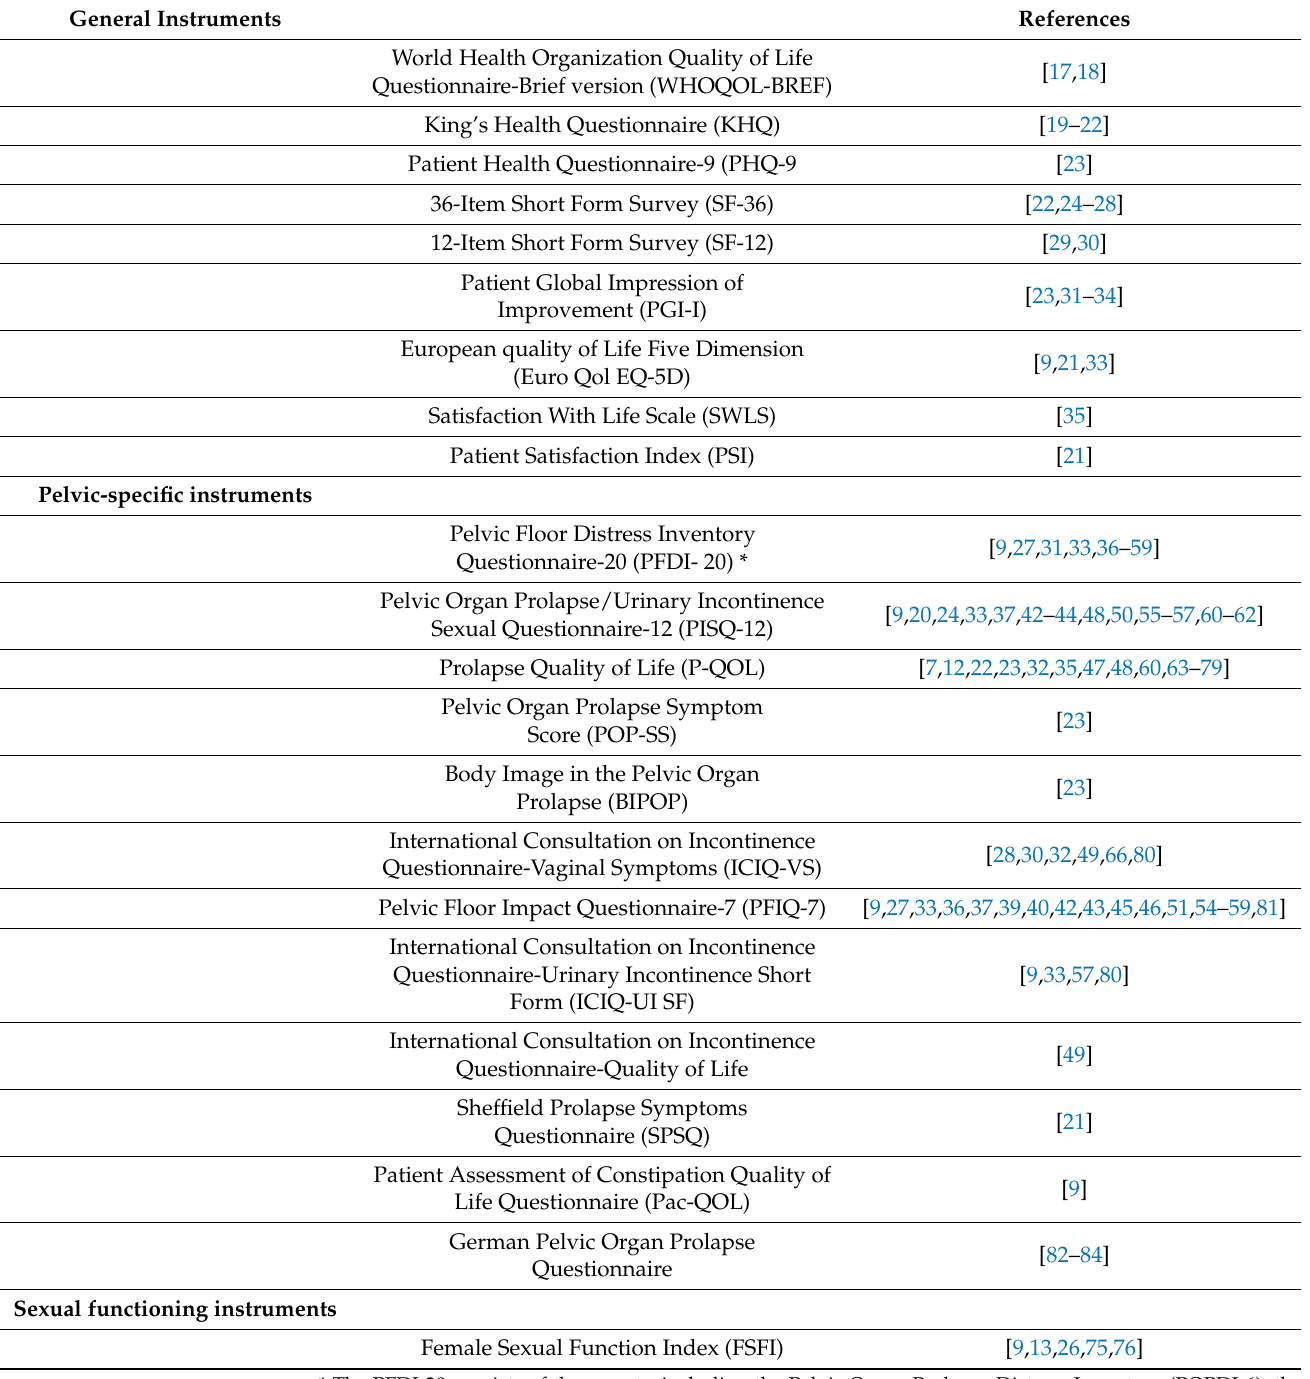
Table 1. Questionnaires used in the recruited